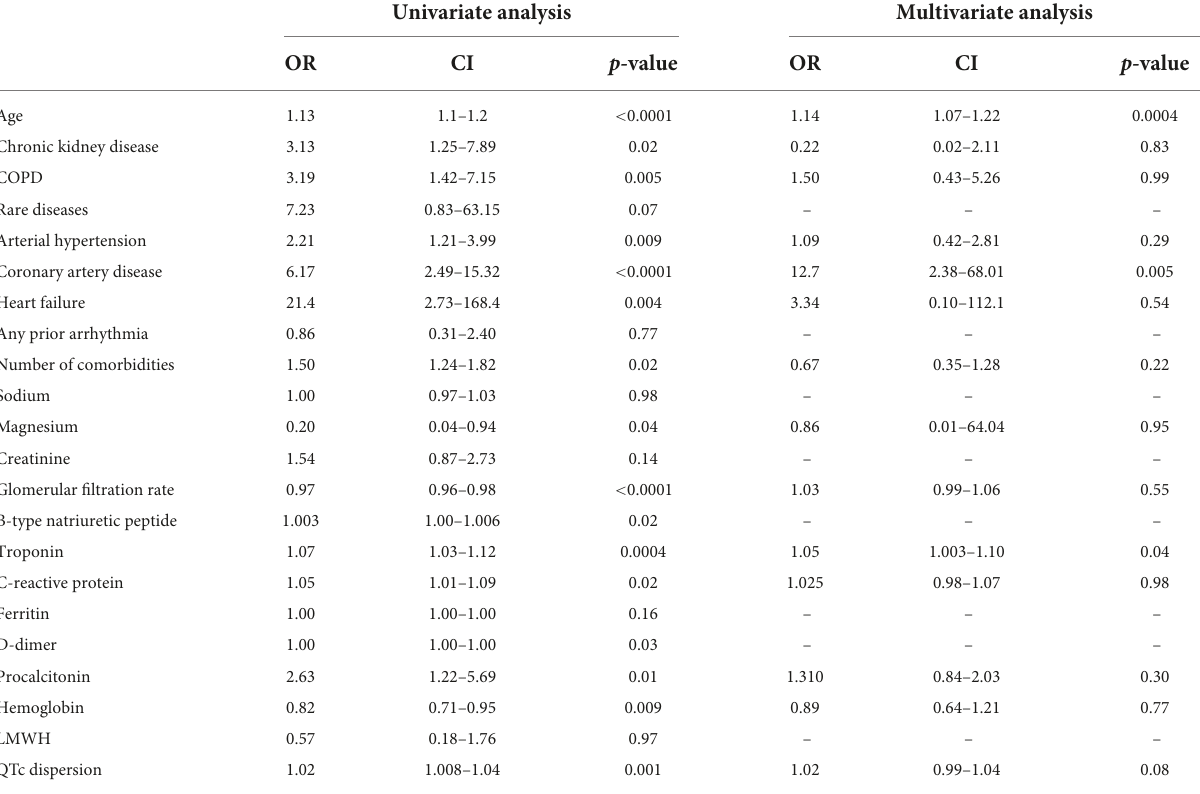
TABLE 5 Univariate and multivariate analyses of risk factors potentially associated with